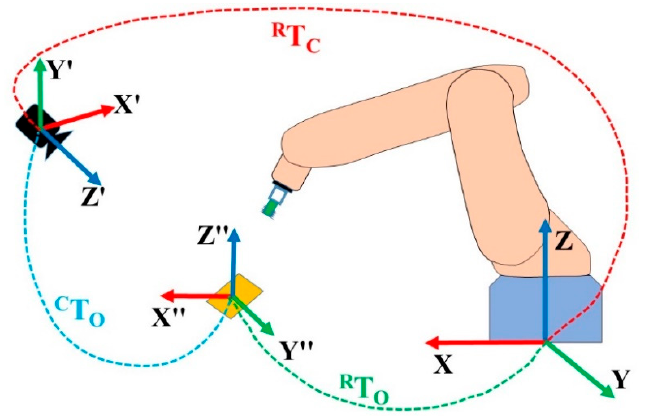
Figure 16. Camera and object position with respect to the robot base.